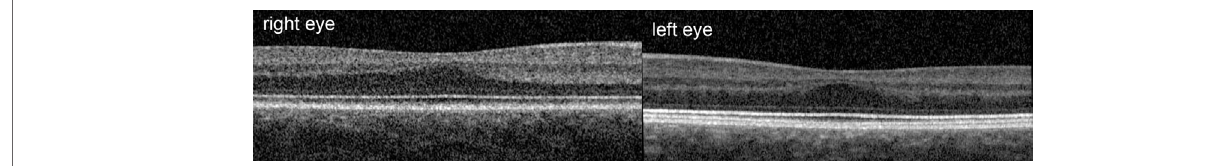
FigUre 1 | Optical coherence tomography scan showed the foveal hypoplasia.